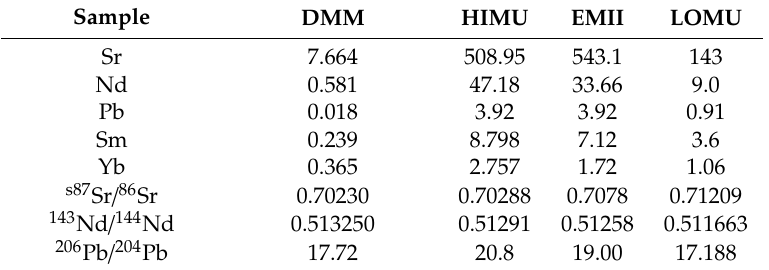
Table 3. Trace element (ppm) and isotope compositions of mixing model